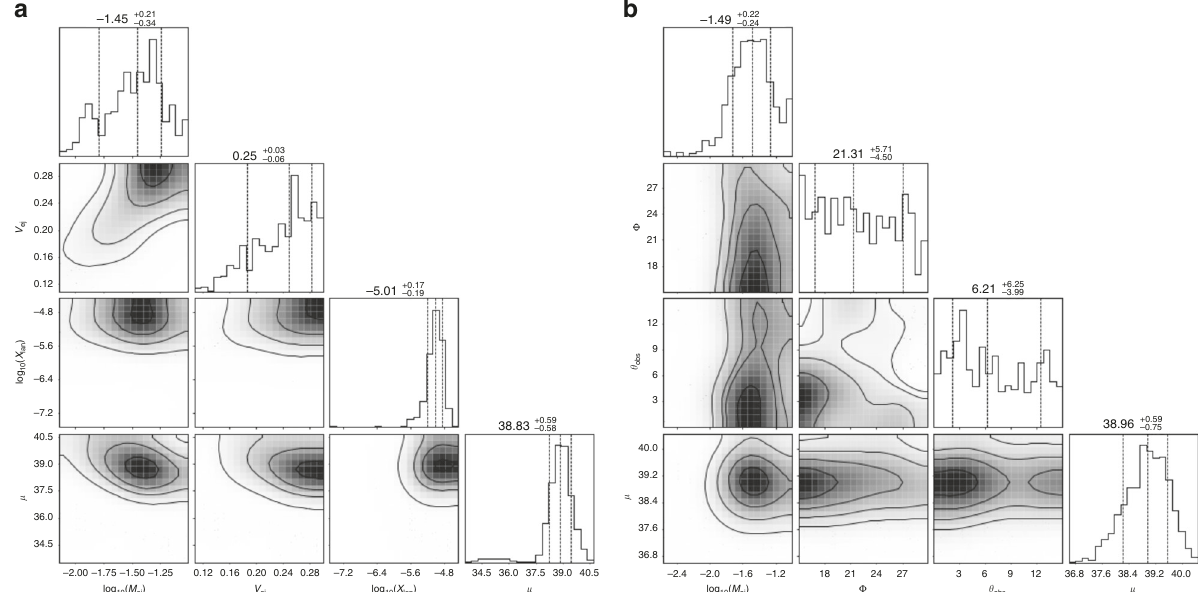
Fig. 6 Corner plots for the model parameters. We show them for both Kasen et al. 24 model ( a ) and the Bulla 25 model ( b ) for GRB 060614. We also show the inferred distance modulus in the last